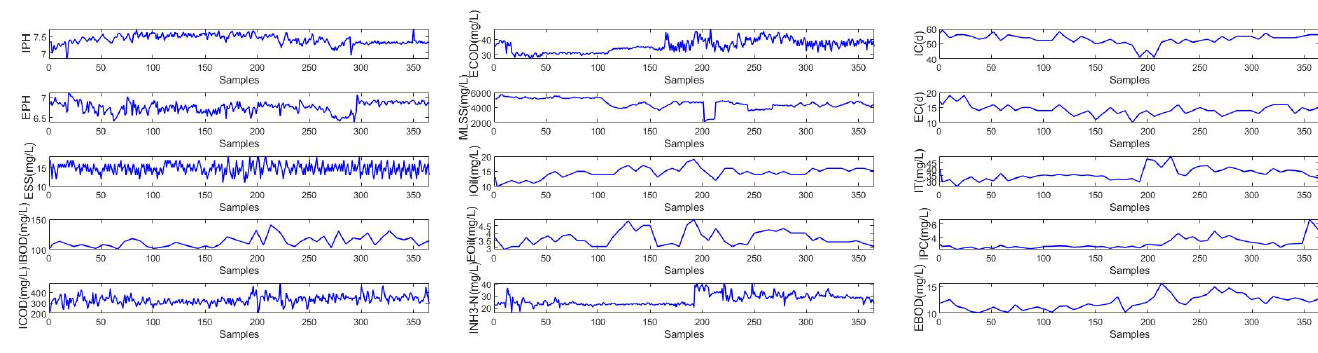
Figure 9. Auxiliary variables of BOD.